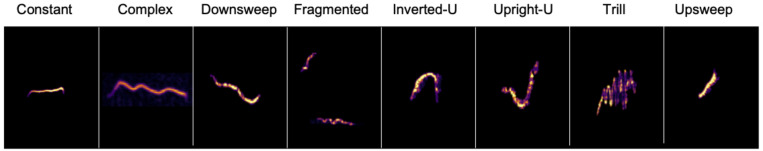
Representative spectrograms of USV call types.